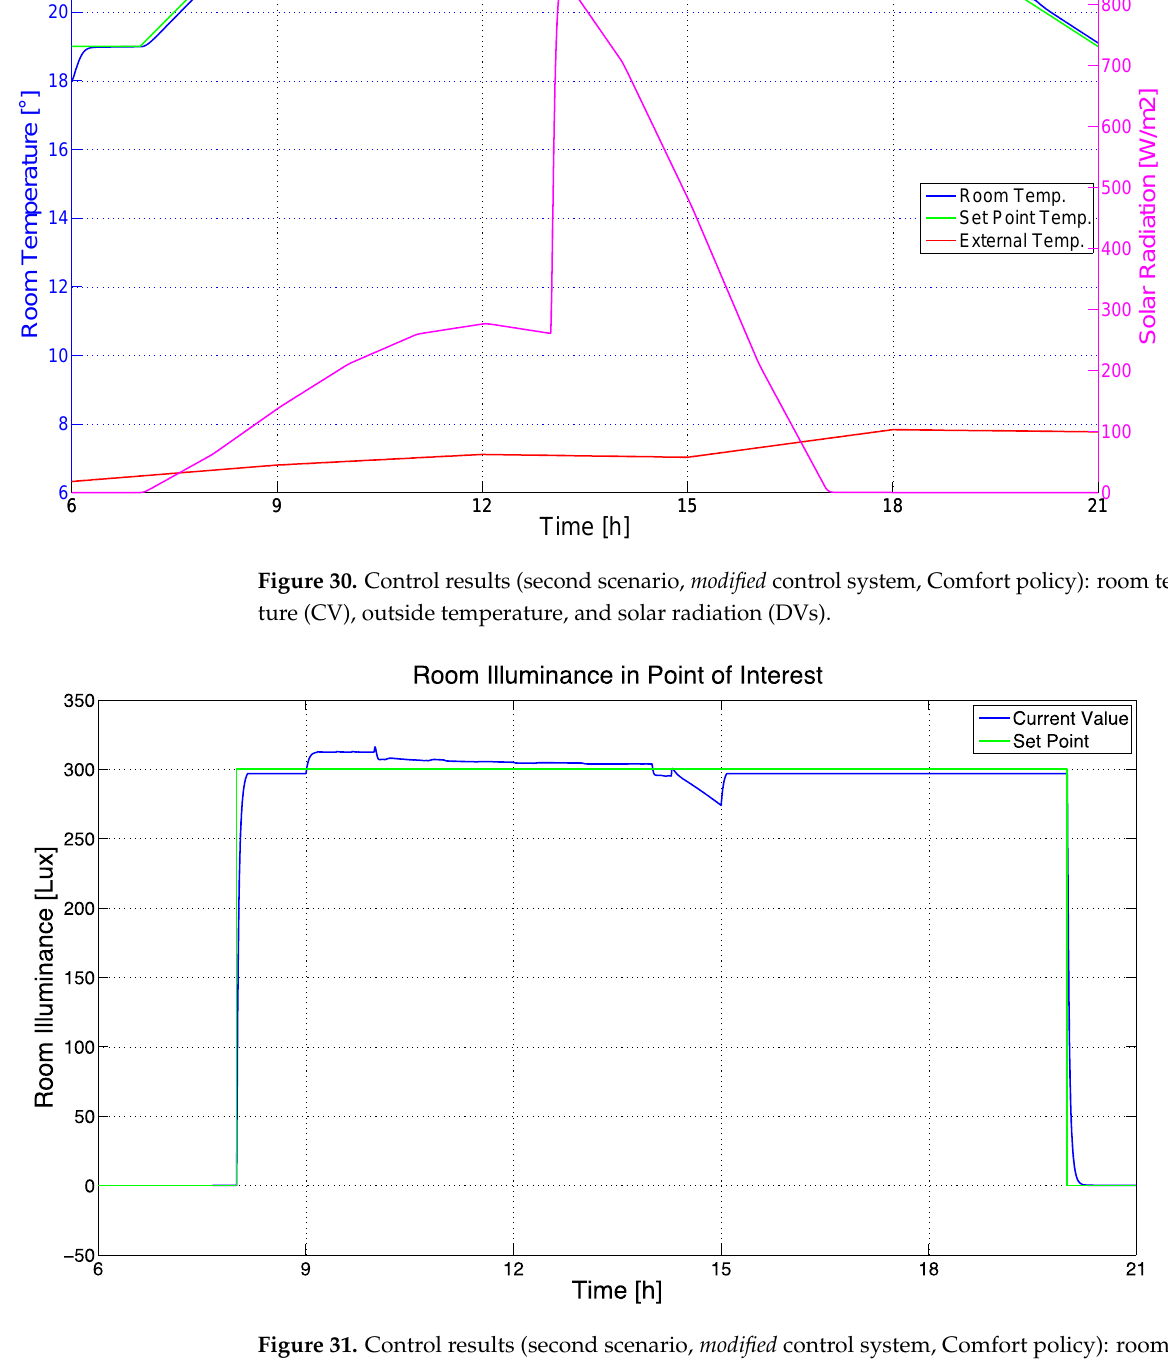
Figure 31. Control results (second scenario, modified control system, Comfort policy): room illumi- nance (CV).